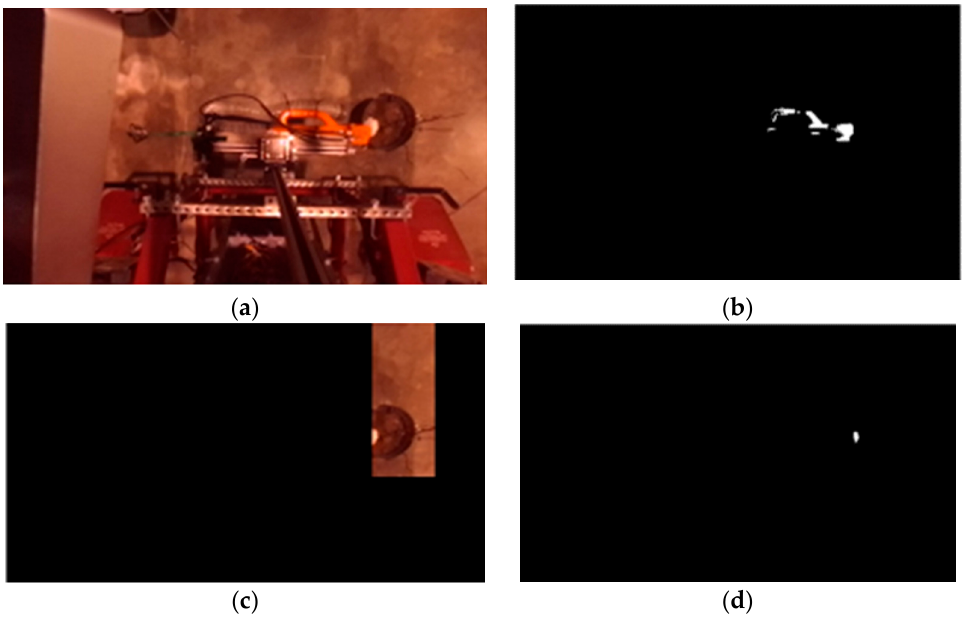
Figure 10. Color segmentation to localize the end-effector of the manipulator: ( a ) RGB image of the manipulator; ( b ) mask image of the end effector; ( c ) masking of all over image parts, leaving only an area that can be reached by the end effector, and, hence, it might contain bolls to pick; and ( d ) masking of the cotton bolls.